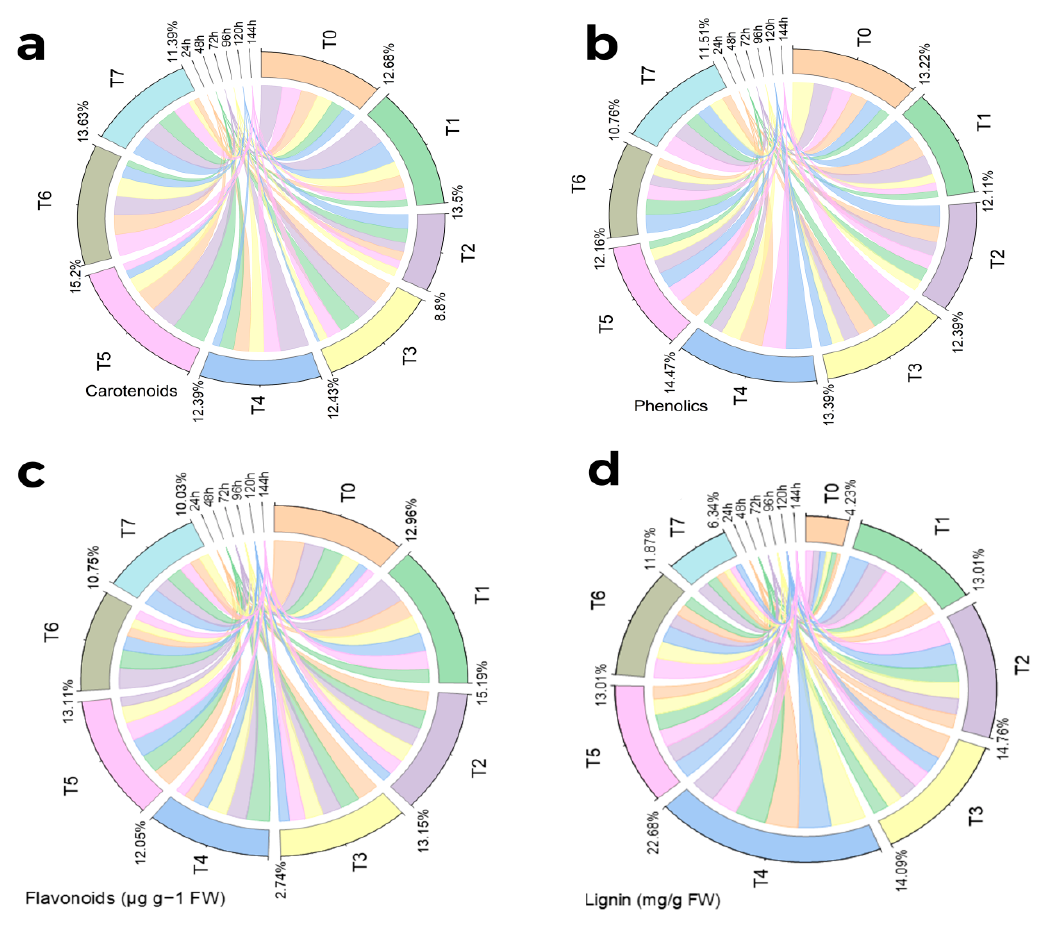
Figure 4. Chord diagram showing effect of different treatments of elicitors on Carotenoids ( a ), Phenolics ( b ), Flavonoids ( c ), and Lignin ( d ) contents of Silybum marianum in hydroponics where Harvest time on x-axis, First = One day (24 h), second = 48 h. Third = 72 h. Fourth = 96 h. Fifth = 120 h. Six = 144 h.where(T0 = control, T1 = methyl jasmonate, T2 = silver nanoparticles, T3 = fungal elicitors, T4 = methyl jasmonate + fungal elicitors, T5 = methyl jasmonate + silver nanoparticles, T6 = fungal elicitors + silver nanoparticles, T7 = methyl jasmonate + silver nanoparticles + fungal elicitors).